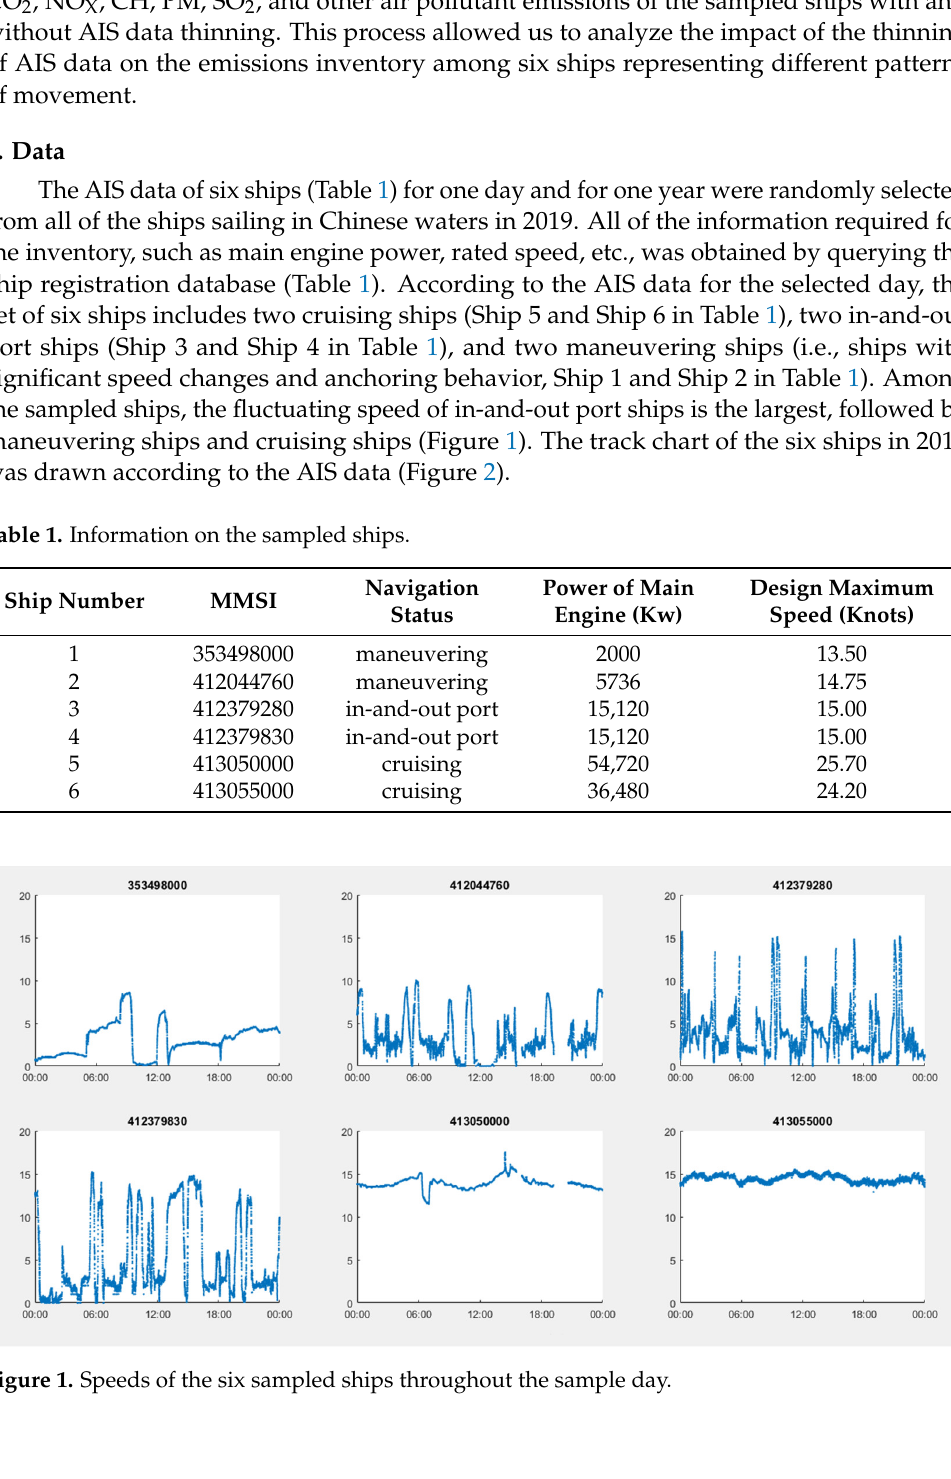
Figure 2. Tracks of the sampled ships in 2019.